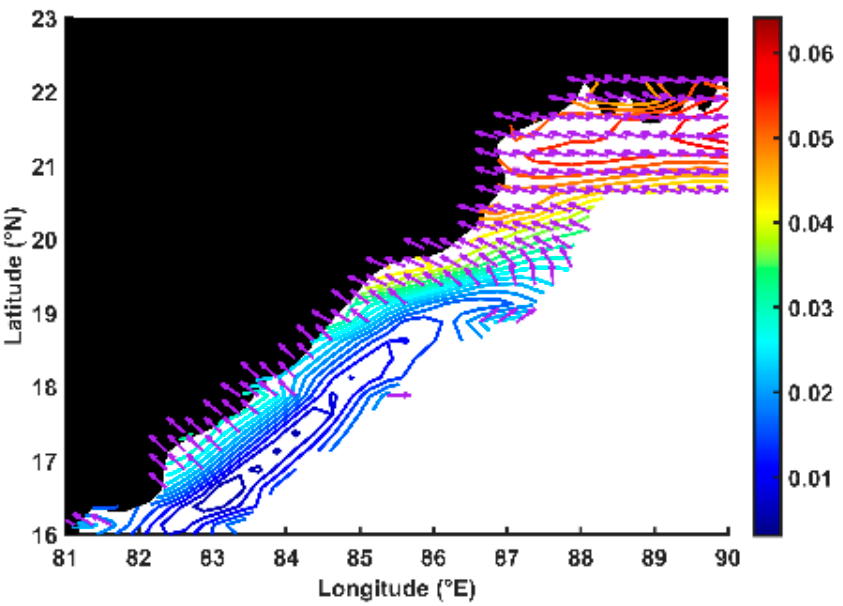
Figure 15. Magnitude (colored contours) and phase (purple arrows) of first mode of CEOF in the northwest BoB.